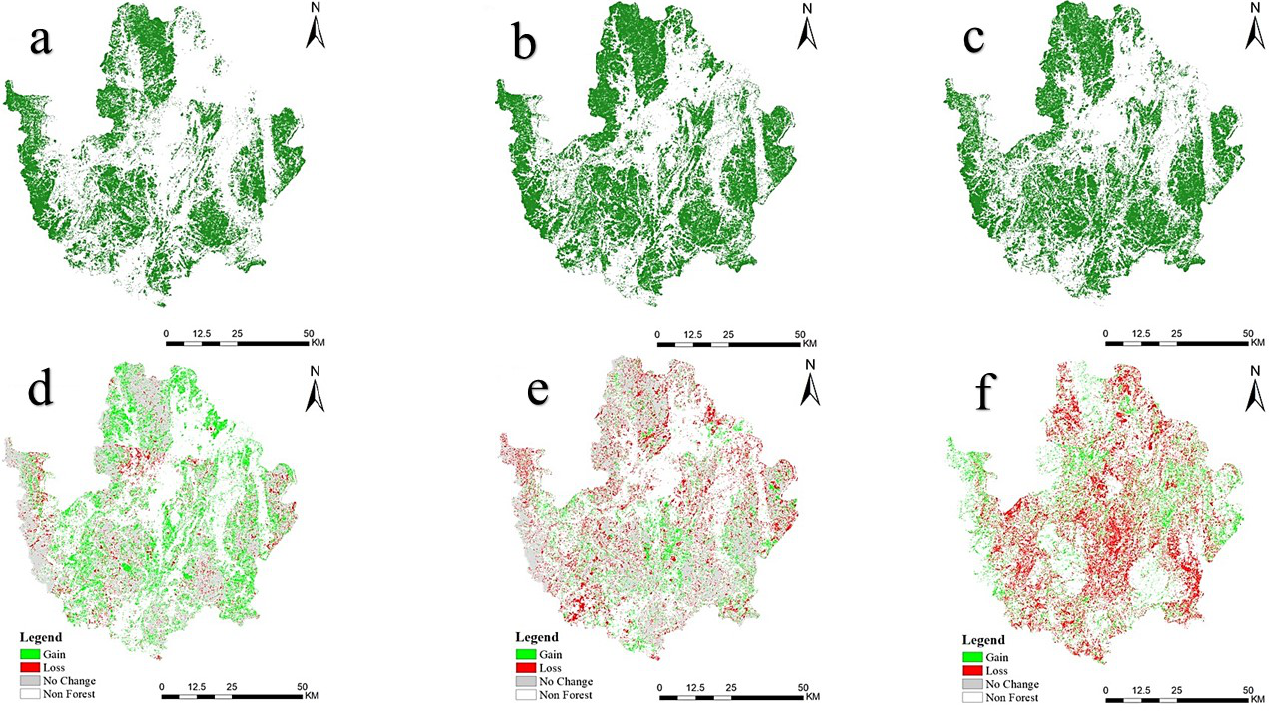
Figure 6. Distribution of forestland in 2010 ( a ); 2015 ( b ); 2019 ( c ); dynamics of forestland in 2010–2015 ( d ); 2015–2019 ( e ); 2010–2019 ( f